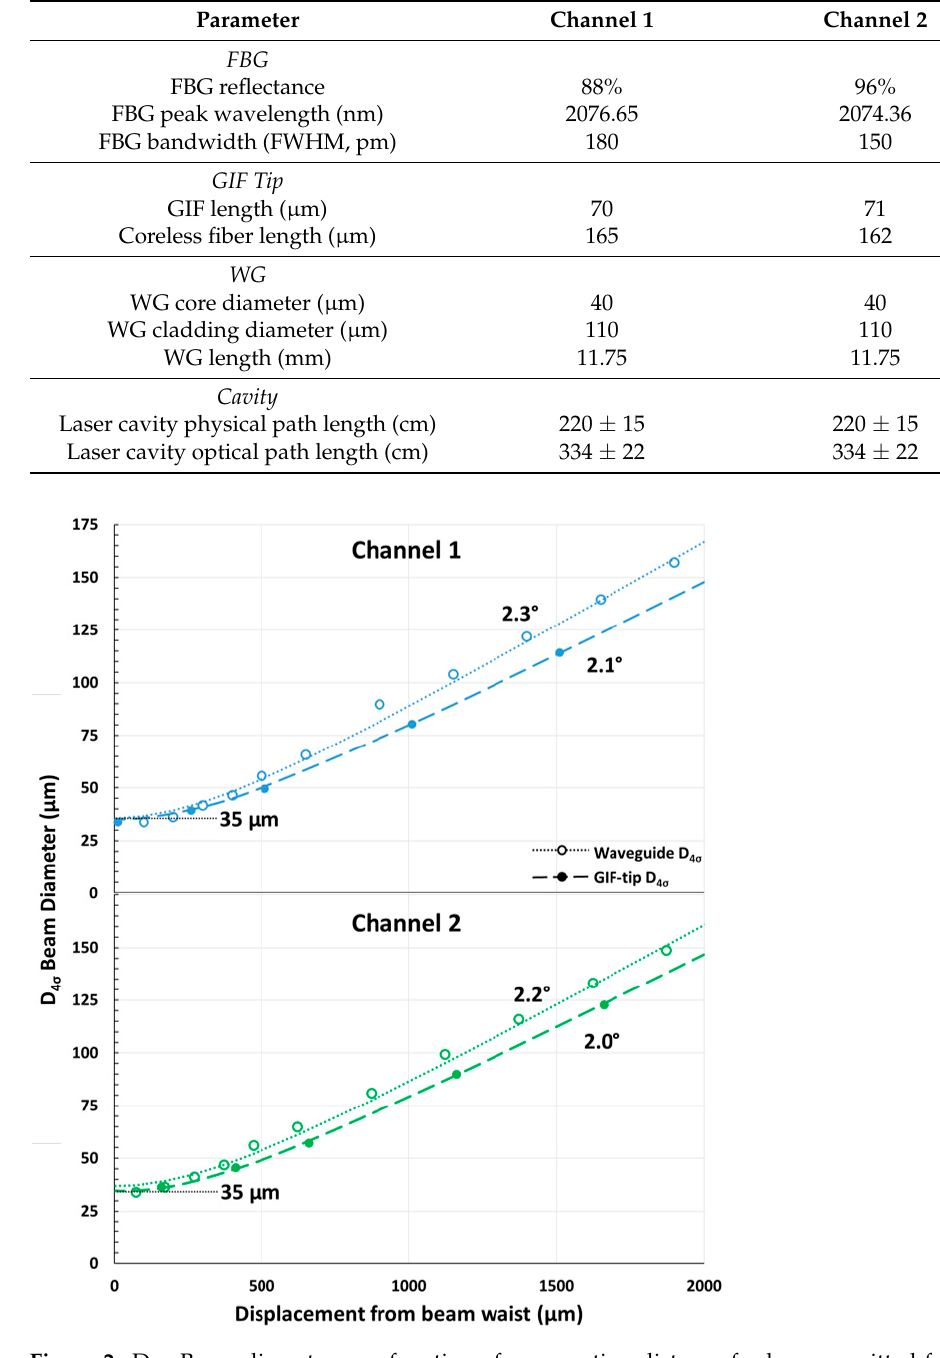
Figure 2. D 4 σ Beam diameter as a function of propagation distance for beams emitted from the WGs (~2075 nm) and GIF-tips (1945 nm), presented for ( top ) channel 1 and ( bottom ) channel 2 ( − 2000 µ m to 0 µ m omitted for clarity). The resulting divergences (half angle) are presented next to their respective fits, and the beam waists were 35 µ